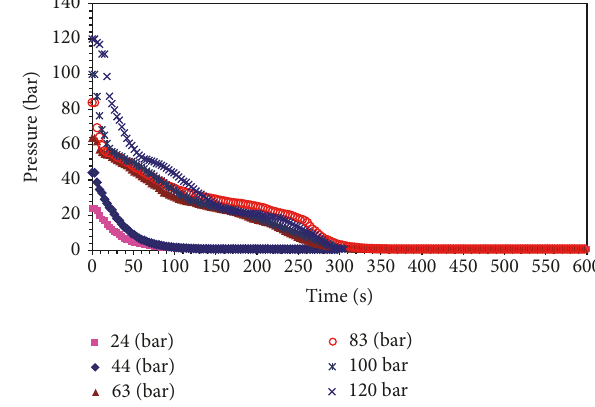
Figure 11: Pressure versus time plot for the depressurization experiments at 100 ∘